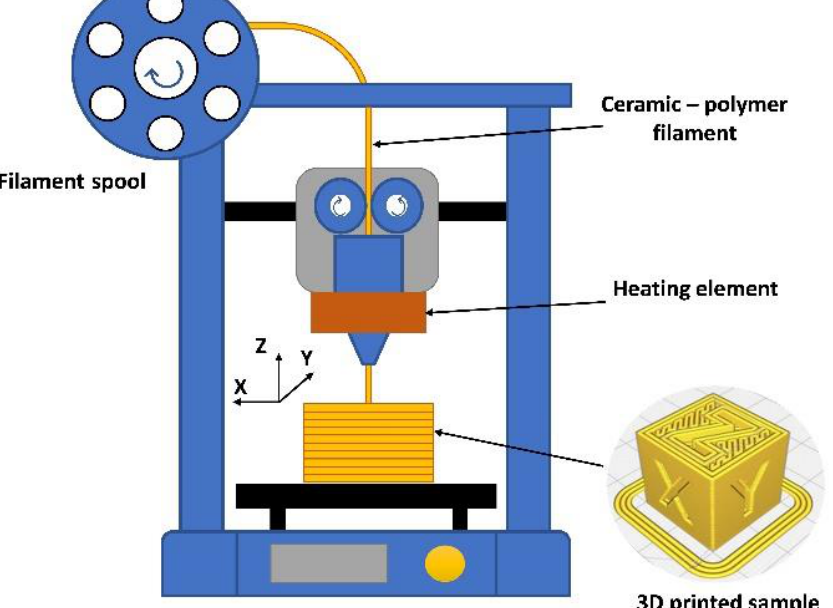
Figure 1. Schematic diagram of FDM/FFF-3D printing.